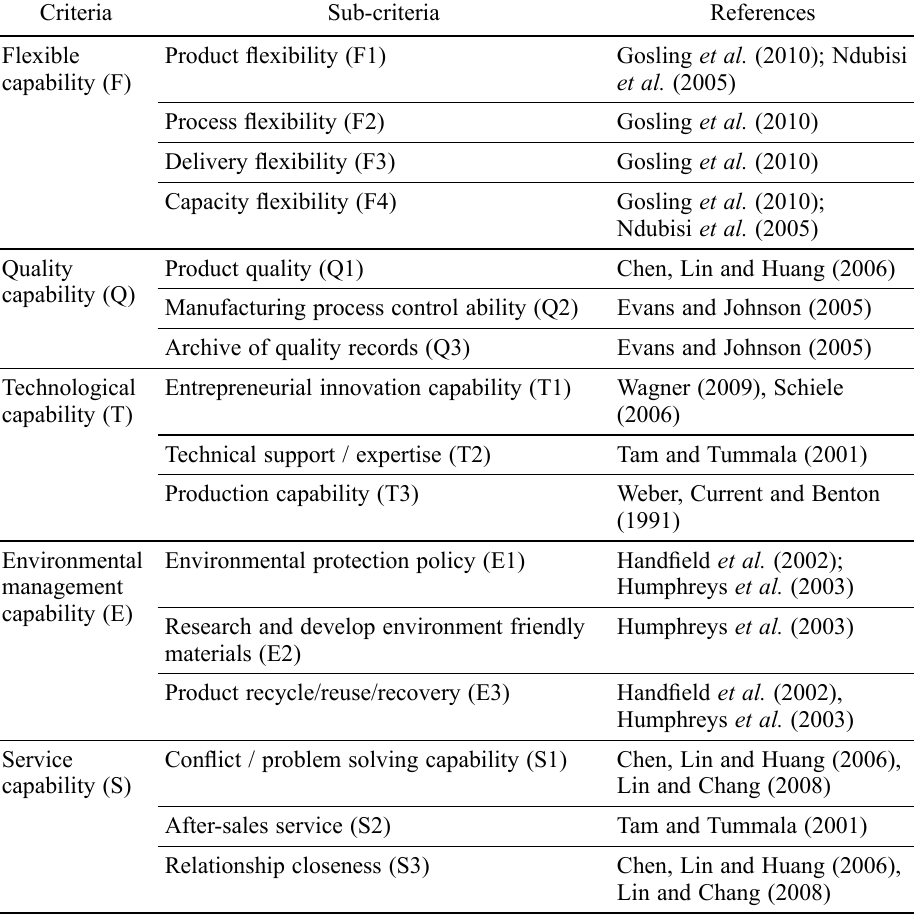
Table 2. The criteria and sub-criteria for supplier selection